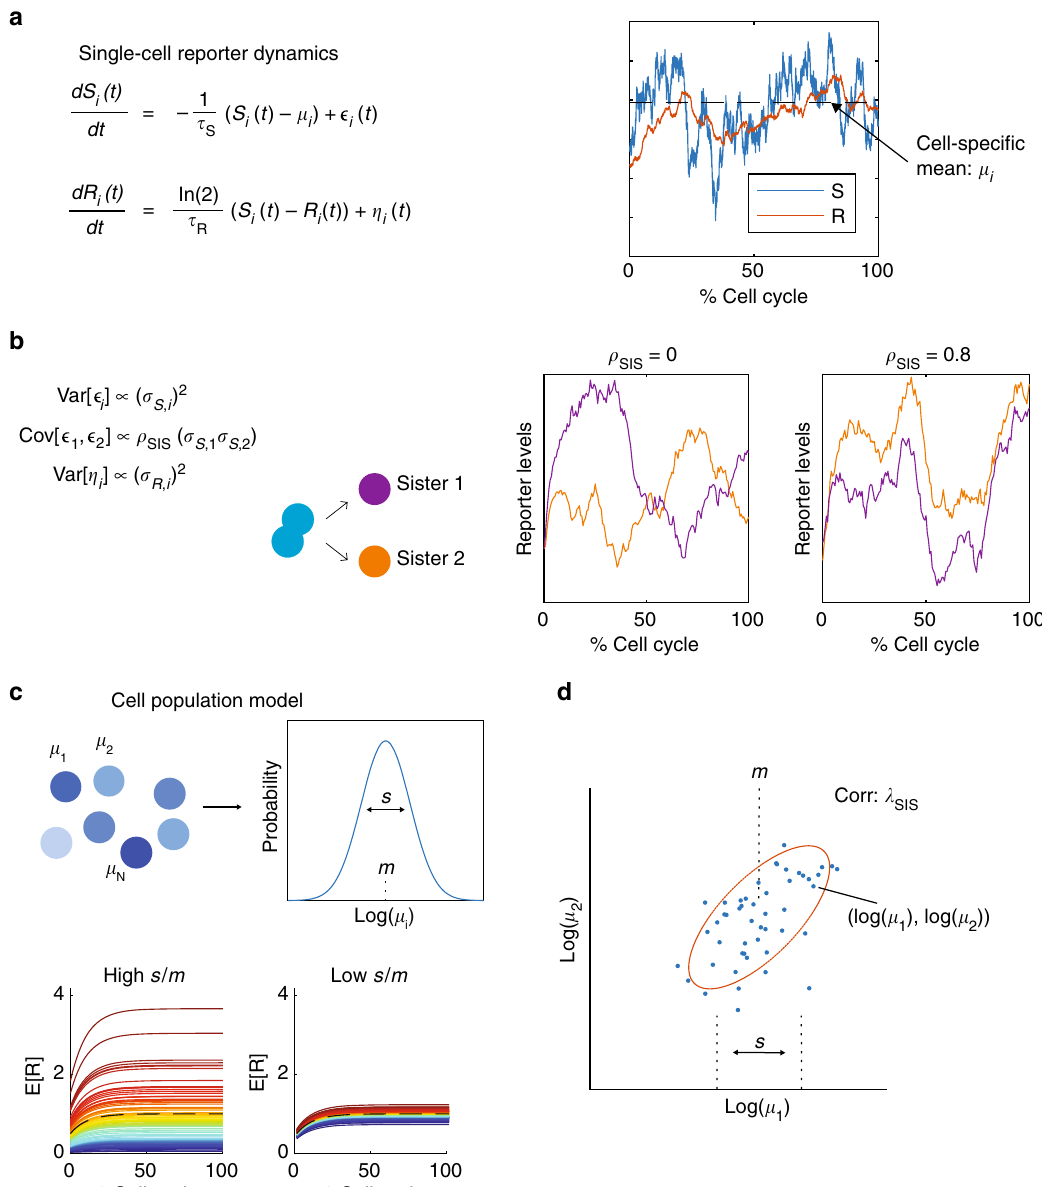
Fig. 3 A hierarchical model of single-cell reporter dynamics in pairs of sister cells. a Single-cell dynamics are modelled probabilistically using stochastic differential equations (Methods). Each cell has a transcriptional activity ( S ) and a bioluminescent reporter ( R ) variable, where S controls the production of R . b To account for stochastic fl uctuations, both S and R are perturbed by noise terms ε and η , respectively. The transcriptional noise ð ϵ Þ experienced in the two sister cells is correlated with parameter ρ SIS , which describes whether sister cell dynamics are independent ( ρ SIS = 0) or if they share a similar shape over the cell cycle ( ρ SIS > 0). c The mean level of S is cell-speci fi c and denoted by μ i for cell i , and the strength of the noise terms for S and R are also cell- speci fi c and are denoted by σ S , i and σ R , i , respectively. The distribution of cell-speci fi c parameters μ i , σ S , i and σ R , i are described at the population level with log-normal distributions. s describes the population level variability in cell-speci fi c means. d The correlation of mean transcriptional levels between sister cells is quanti fi ed with λ